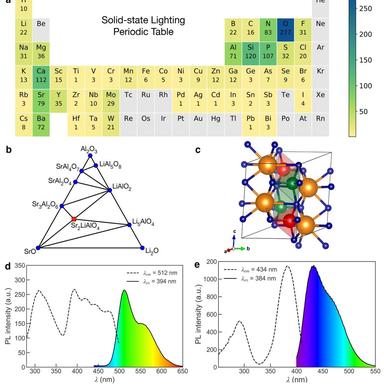
(a) Frequency at which each element appears in compounds having the word "phosphor" in the publication title in the 2017 version of ICSD. (b) DFT 0 K SrO-Li2O-Al2O3 phase diagram. Blue circles, known stable phases in the Materials Project database ; red square, new stable quaternary phase, Sr2LiAlO4. (c) Unit cell and Sr local environment (in Å) of the Sr2LiAlO4 crystal. (d, e) Measured excitation and emission spectra of (d) Sr2LiAlO4:0.005Eu2+ and (e) Sr2LiAlO4:0.005Ce3+ phosphors. Colors are i